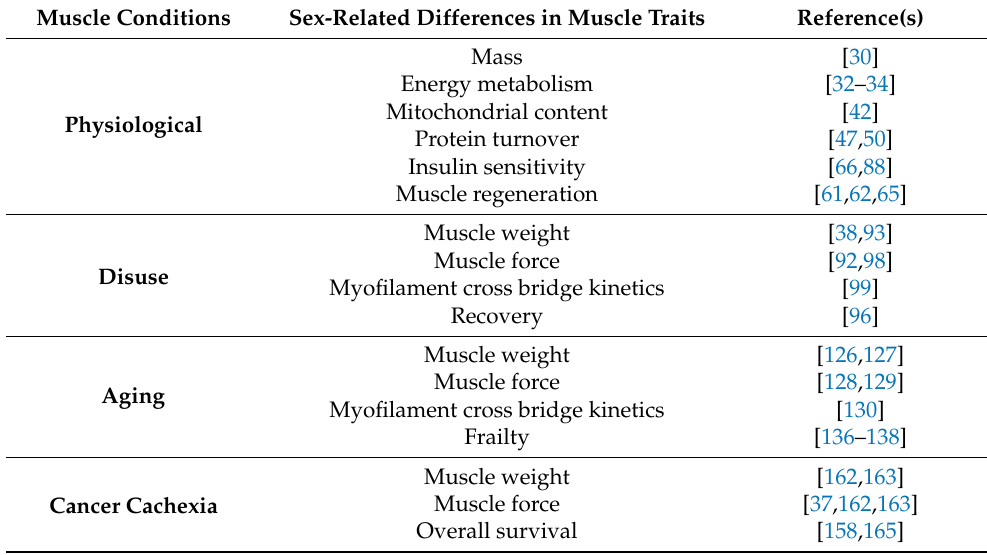
Table 1. Sex-related differences in muscle phenotype under physiological or pathological